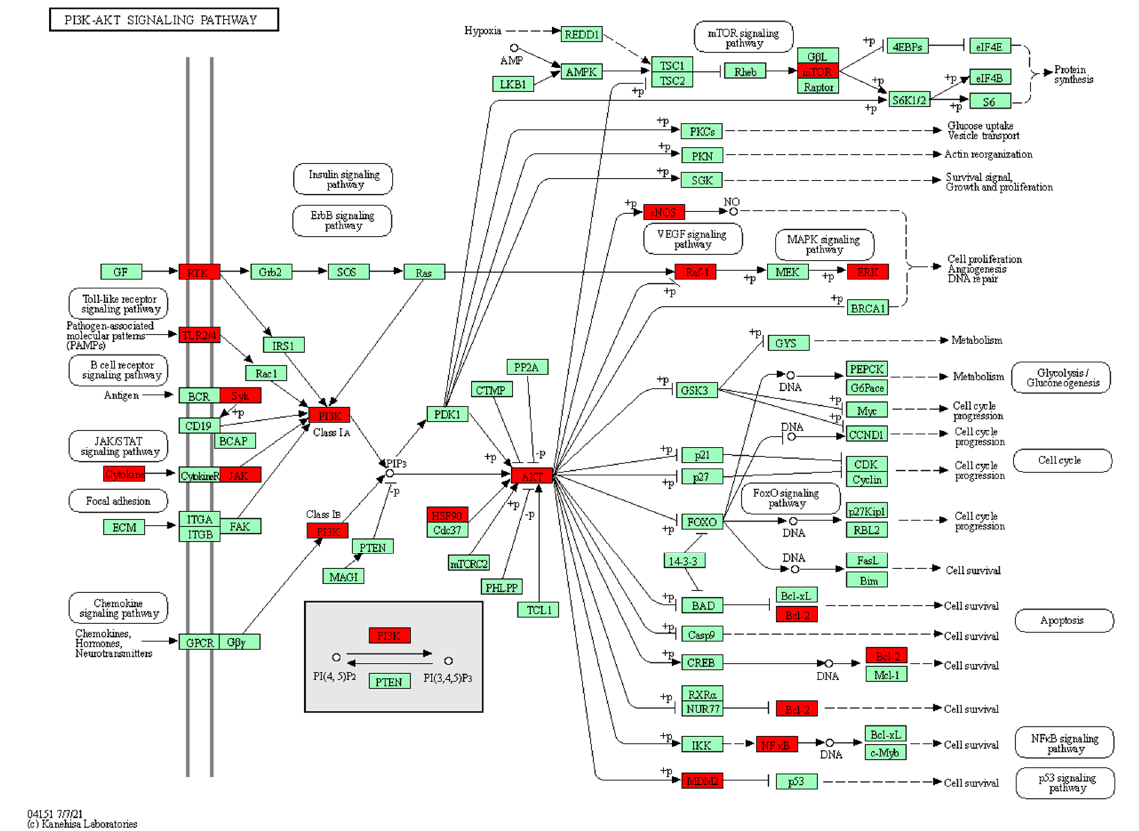
Figure 7. PI3K-Akt signaling pathway. (Red represents the intersection targets of ZBDHP against SLE in the signaling pathway).